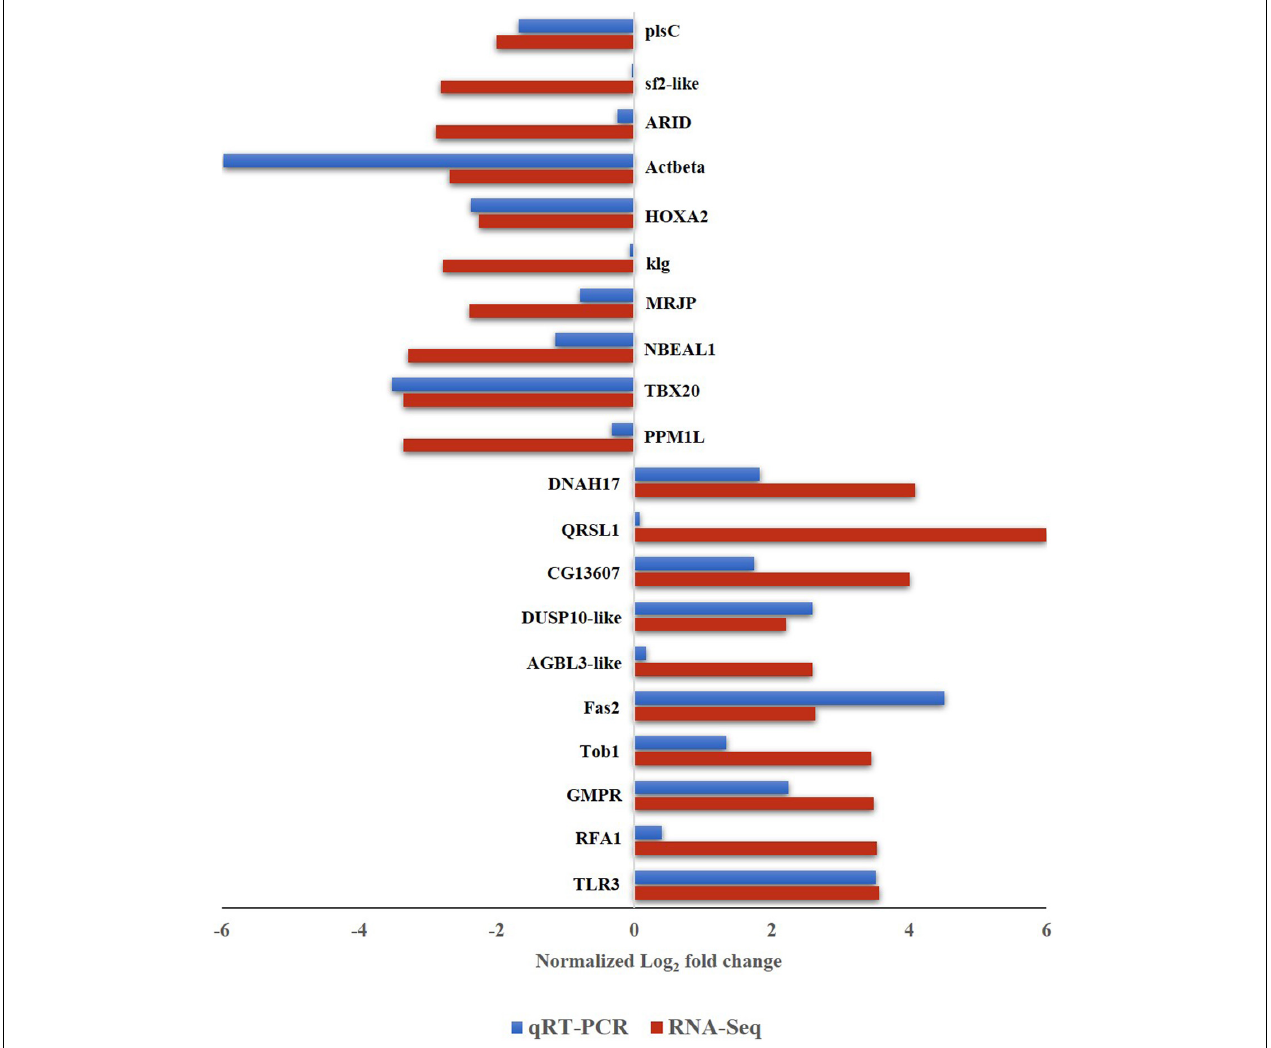
FIGURE 4 | Expression of B. tabaci Asia II 1 putative genes in response to ChiLCV infection in RNA-Seq and RT-qPCR. The values of log 2 -fold changes calculated in RNA-Seq analysis were in accordance with the RT-qPCR fold change